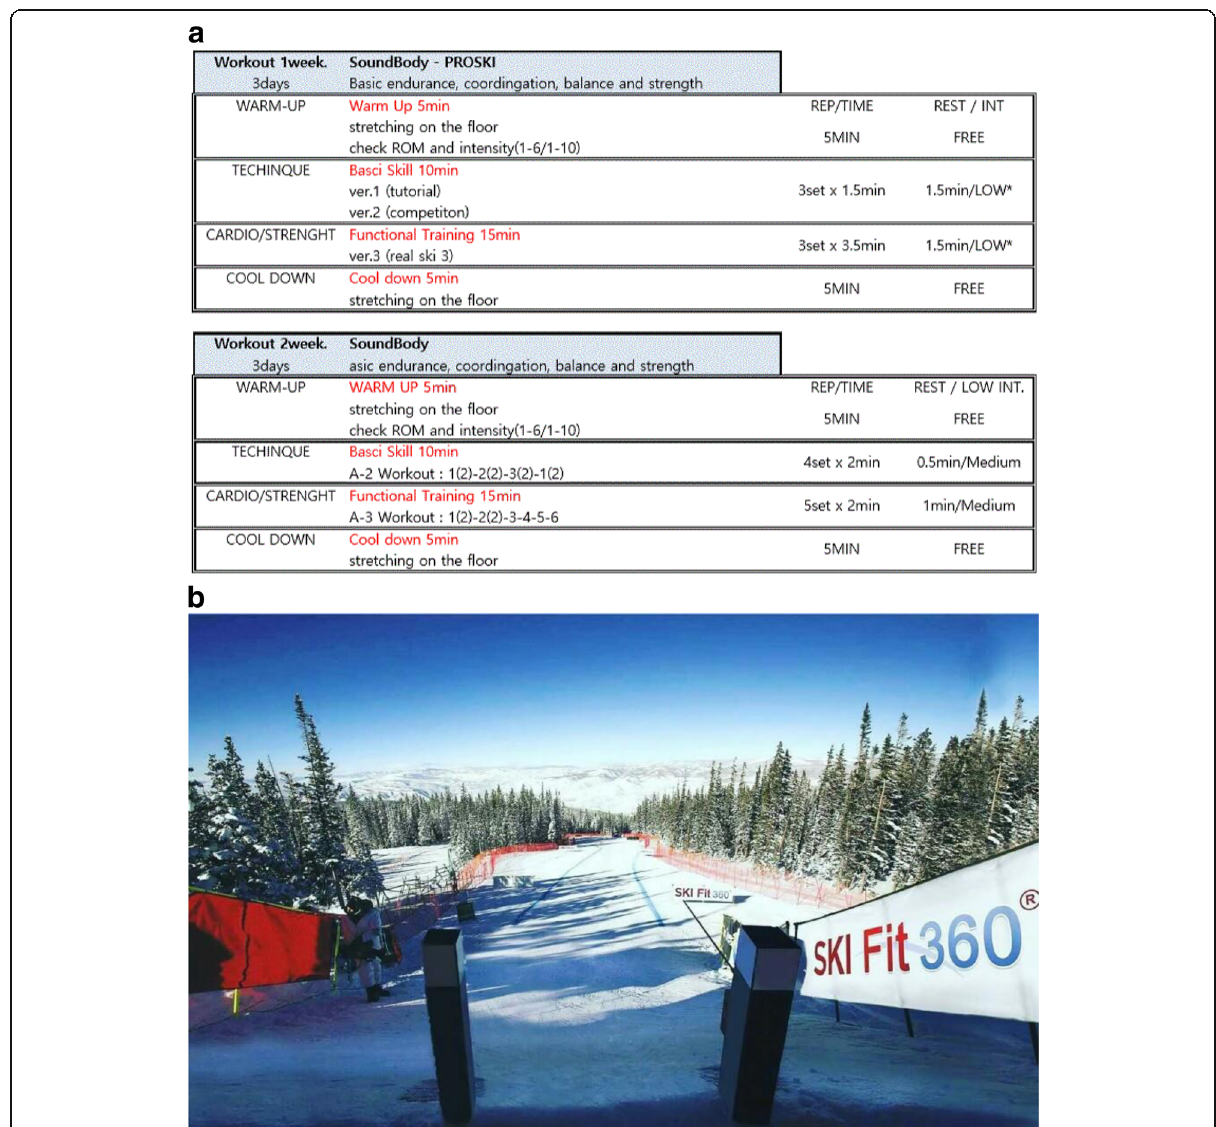
Fig. 1 The proposed sports VR system. a 4-week workout. b A snapshot of virtual training images integrated with